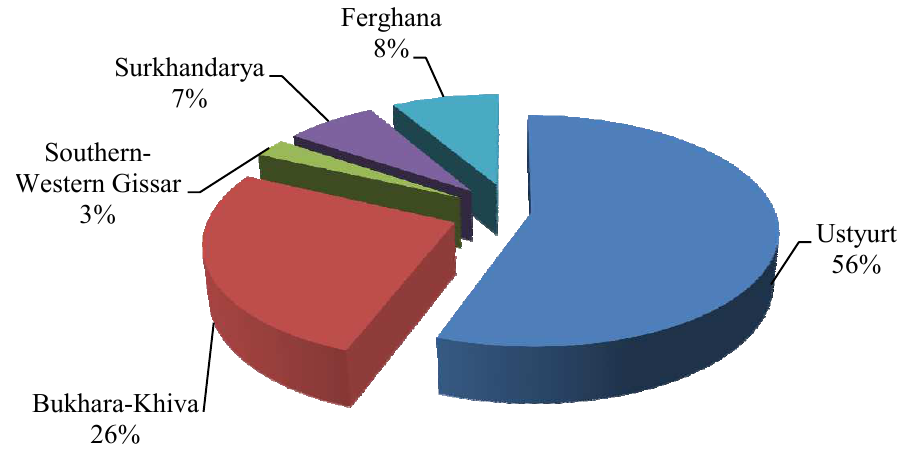
Fig. 1. The share of regions in the total area of proven oil and gas reserves 1.1. Trends in the oil and gas condensate sector.